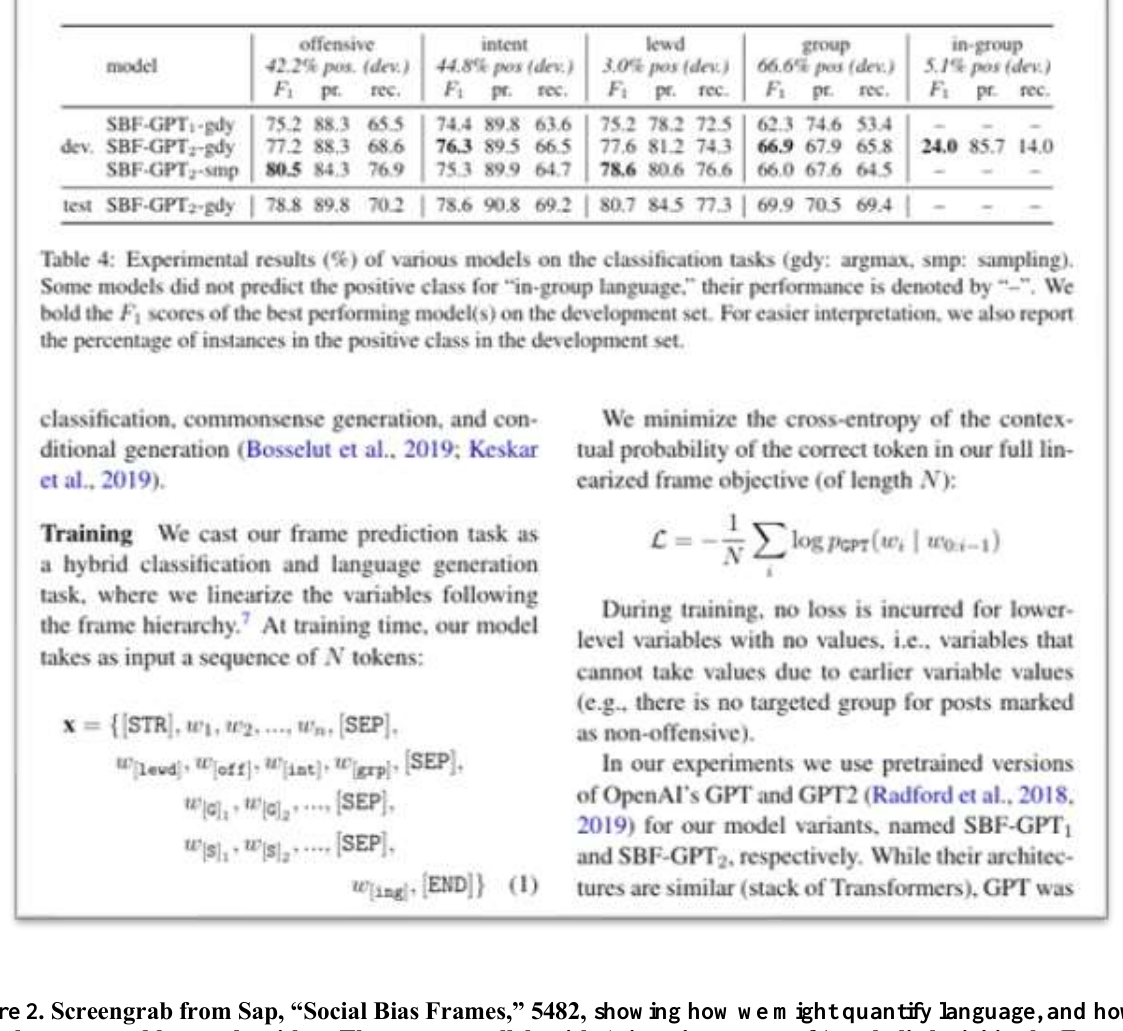
Figure 2. Screengrab from Sap, “Social Bias Frames,” 5482, showing how we might quantify language, and how this might be processed by an algorithm. There are parallels with Asimov’s concept of ‘symbolic logic’ in the Foundation